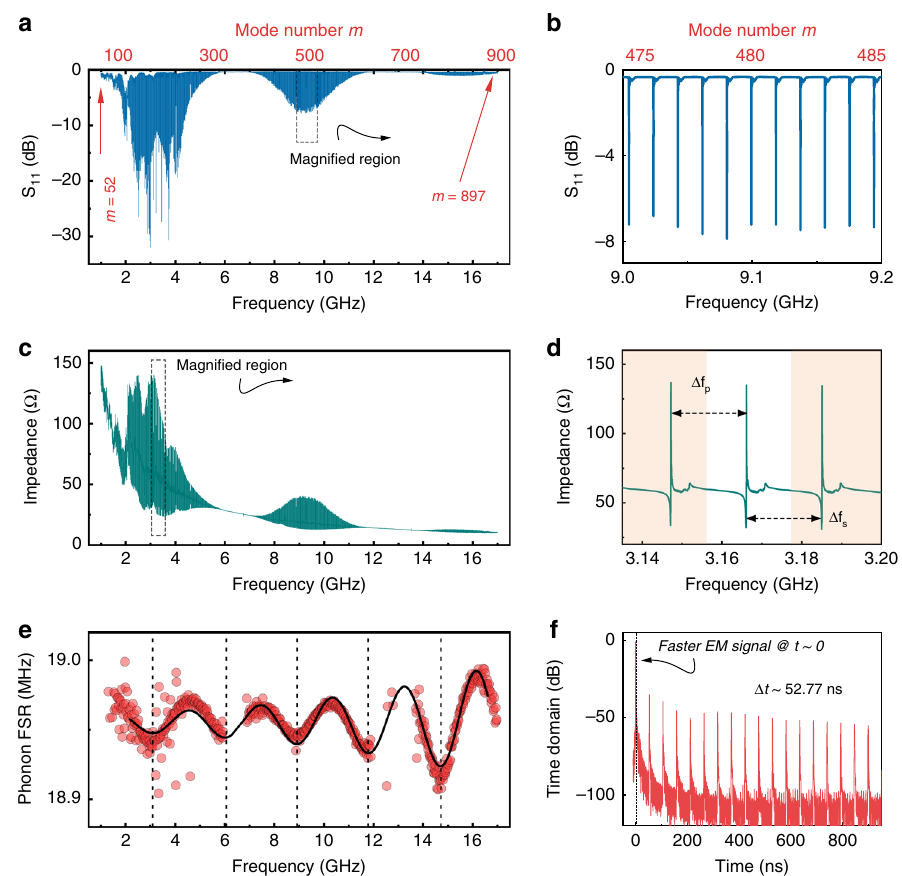
Fig. 2 Microwave measurements of the epi-HBAR at 7.2 K. a Microwave re fl ection spectrum ( S 11 ( ω )) for the epi-HBAR from 1 to 17 GHz (encompassing m = 52 to m = 897). The S ω ) spectrum demonstrates the superposition of the transduction envelope and the cavity modes. The transduction envelope 11 ( encompasses three odd-numbered modes of the Al/GaN/NbN transducer. At low frequencies (<2.5 GHz), the presence of unwanted SAW or shear modes distorts the spectral response slightly. b Magni fi ed range of S 11 ( ω ) clearly shows periodic, sharp epi-HBAR phonon modes separated by an average FSR of ~18.95 MHz. c The electromechanical impedance | Z 11 ( ω )| has a global hyperbolic response (from the static electrical capacitance), overlaid by the impedance of the epi-HBAR phonon modes. d A magni fi ed section of | Z 11 ( ω )| illustrates the series (parallel) resonance f s ( f p ) corresponding to the minimum (maximum) impedance. The mode separation between adjacent resonances Δ f s (or Δ f p ) is the free spectral range (FSR) of the epi-HBAR. e Due to the composite nature of the epi-HBAR, the FSR is not constant across the spectrum, but good acoustic impedance matching ensures a smooth